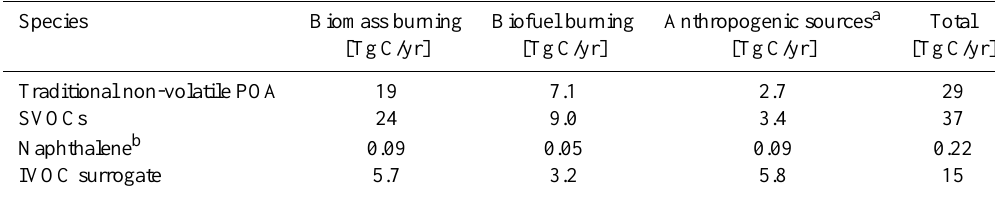
Table 2. Emissions of primary low-volatility organic compounds (year 2000).